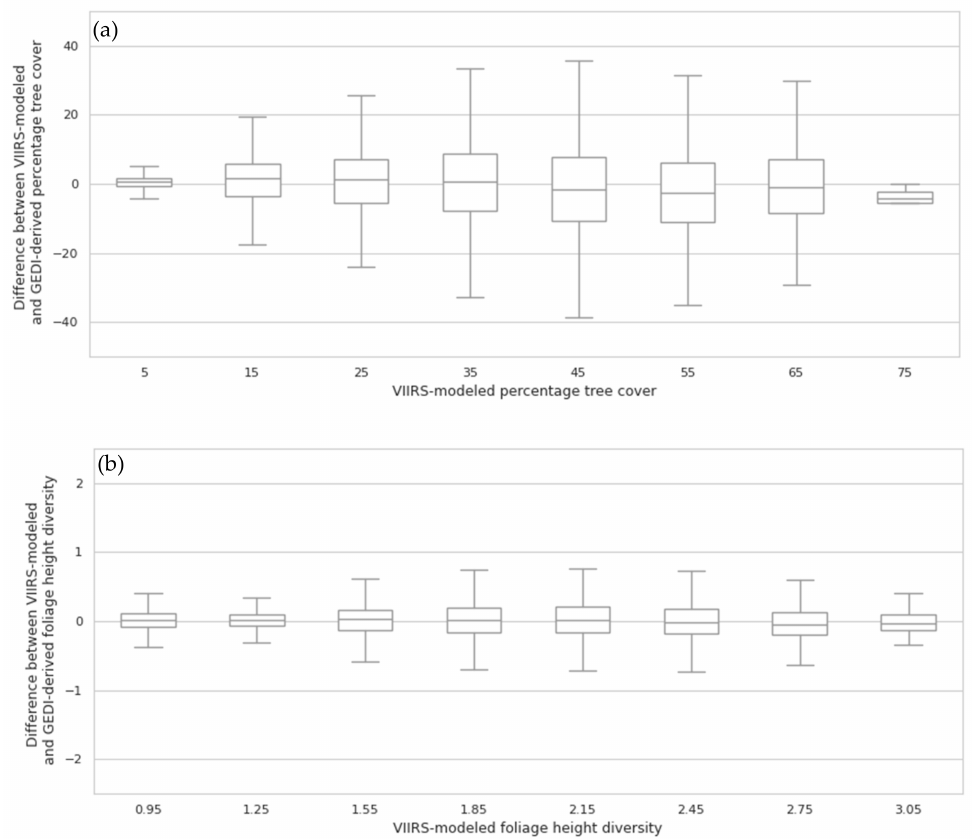
Figure 4. Distribution of differences between ( a ) VIIRS-modeled and GEDI-derived fraction cover; and ( b ) VIIRS-modeled and GEDI-derived foliage height